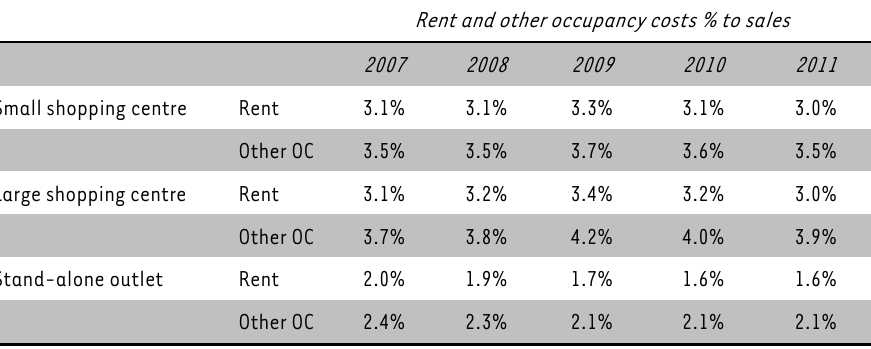
TABLE 8: Summary of rent and other occupancy costs % to sales by retail